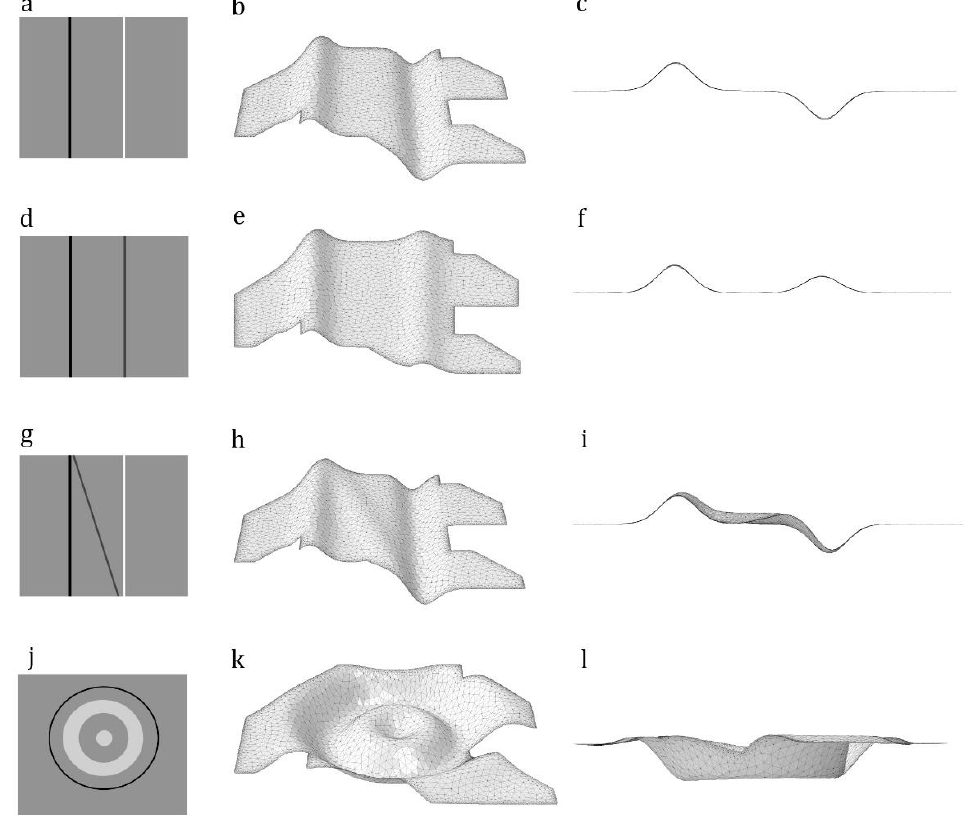
Figure 4. Modeling of out-of-plane domains. The use of different secondary images in combination with the same input image, as shown in Figure 3a, results in the development of models with different